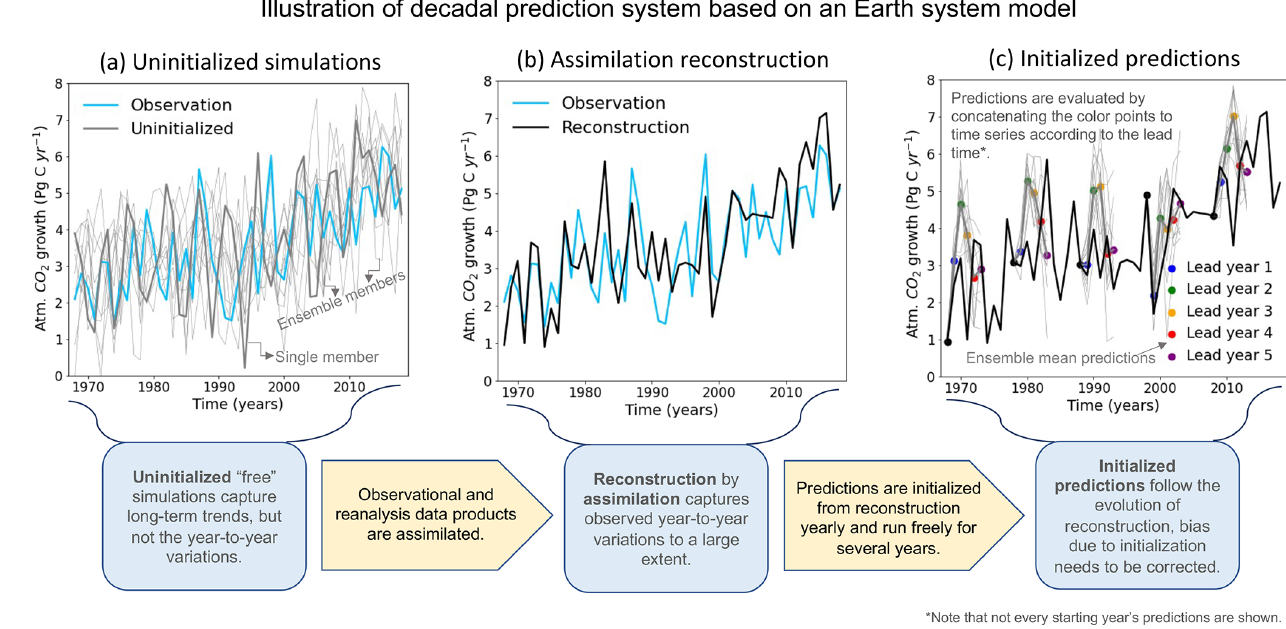
Figure 1. Illustration of the decadal prediction system based on the MPI Earth system model. The illustrated time series of the atmospheric CO 2 growth rate shows annual means from model simulations plotted together with observations from the Global Carbon Project (GCP). We conduct three sets of simulations (from left to right in sequential order): (a) uninitialized “free” simulations, which are the same as the freely evolving Coupled Model Intercomparison Project (CMIP) historical type simulations, (b) an assimilation simulation to reconstruct the evolution of the climate and carbon cycle towards the real world by nudging the model towards observation and reanalysis data during its integration, and (c) initialized predictions started from reconstruction states produced by the assimilation simulation and integrated freely (i.e., no nudging towards observations) for 5 years. The time series in (a) shows that the uninitialized simulations capture the long-term trend well, but the year-to-year variations are out of phase with the observations. The time series in (b) shows that the assimilation simulation forces the variations in the uninitialized freely run simulation towards the real world and results in a reconstruction that is closer to the observations. Panel (c) shows the reconstruction together with the 5-year-long initialized predictions (i.e., hindcasts). To make the illustration more clear, only predictions with starting years at 10-year intervals are